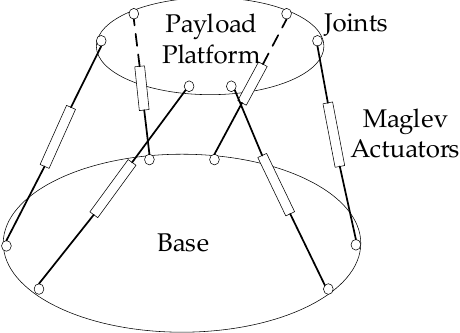
Figure 1. Structure diagram of a classical Stewart platform.